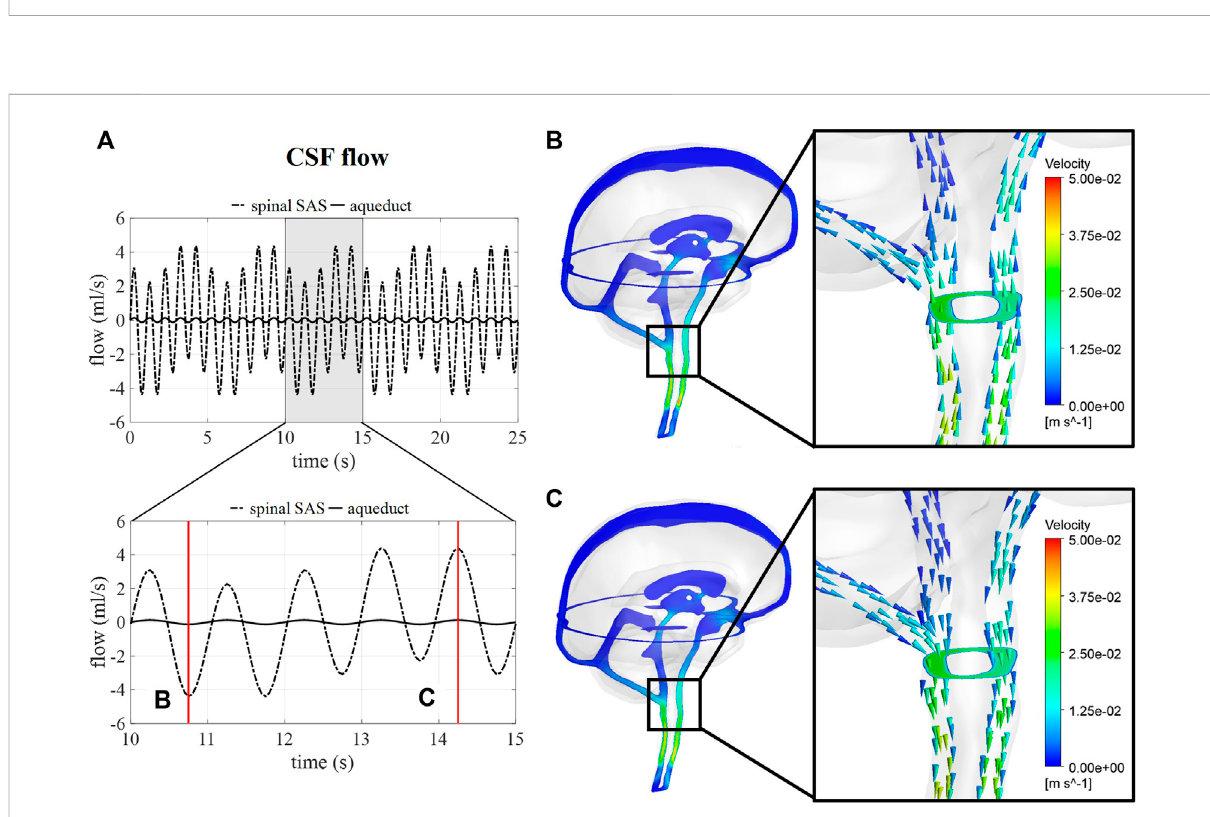
FIGURE 5 CSF fl owandvelocitysimulationsforcase (B)(A) CSF fl owthroughacross-sectionofthecerebralaqueductandthespinalSASfor25 sandthen zoomed in for 5 s. (B) and (C) CSF velocities after 10.75 and 14.25 s,